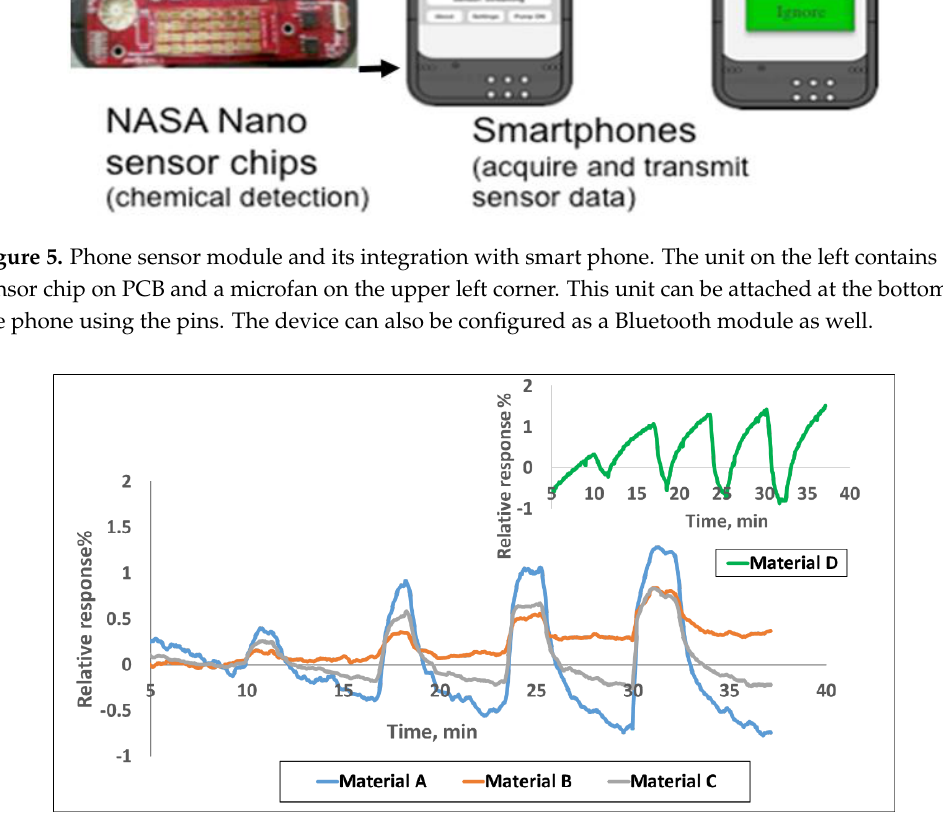
Figure 6. Responses of various sensor materials to 2, 5, 10, 25 ppm CH 4 using the smartphone sensor module.